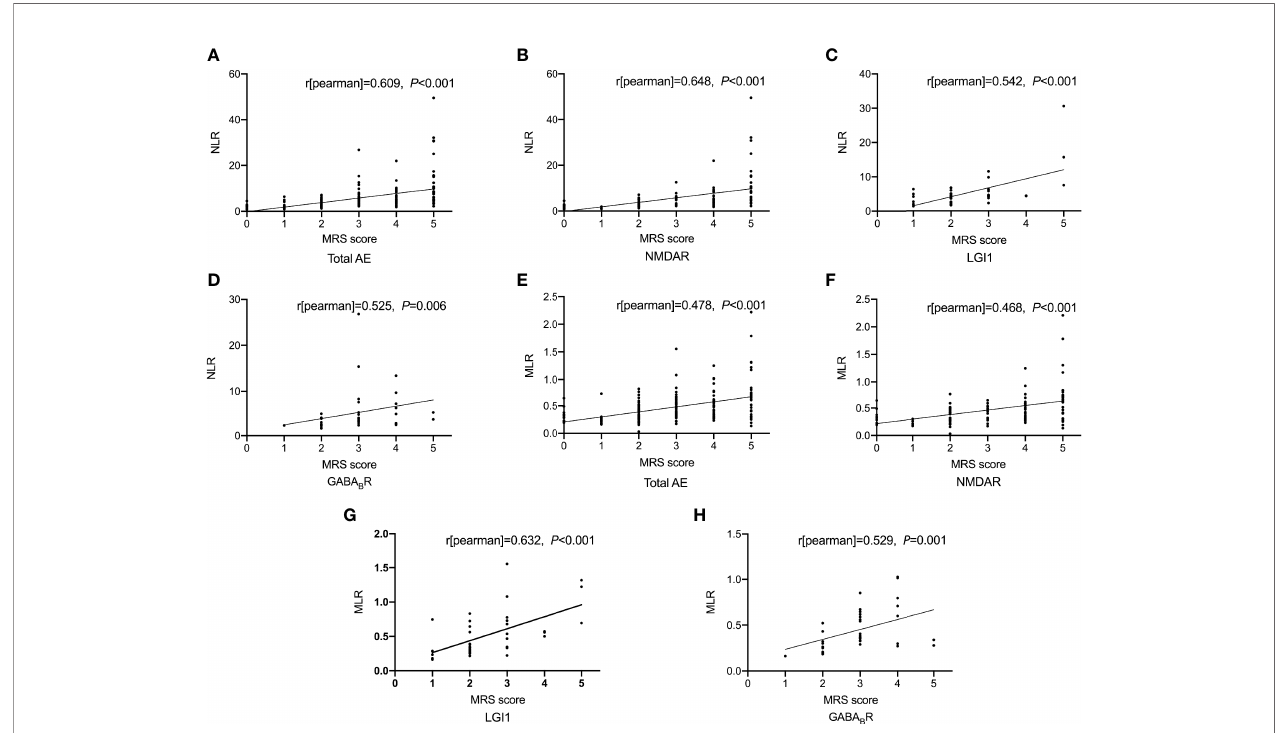
FIGURE 2 | Correlations of NLR and MLR with the mRS score. Correlation between NLR and the mRS score (A-D) ; Correlation between MLR and the mRS score (E-H) . AE, autoimmune encephalitis; NMDAR, N-methyl-D-aspartate receptor; LGI1, leucine-rich glioma inactivated 1; GABA B R, g -aminobutyric acid type B receptor; mRS, modi fi ed Rankin Scale; NLR, neutrophil-to-lymphocyte ratio; MLR, monocyte-to-lymphocyte